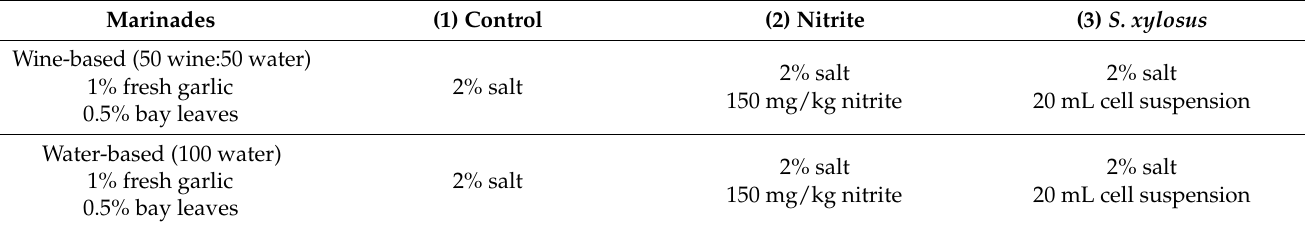
Table 1. Formulations tested in the